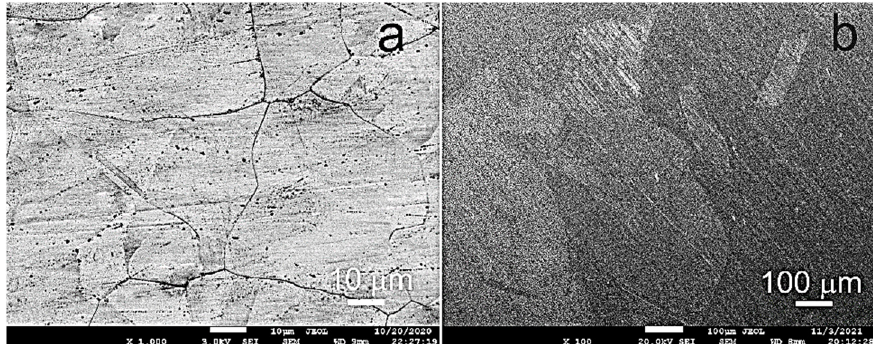
Figure 1. SEM images of the Fe–Mn–Pd alloy after forging ( a ) and annealing ( b ). Usually, during the deformation of Fe-Mn alloys, an γ → ε martensitic transformation occurs [34,35]. However, during four ECAP passes at a deformation temperature of 300 °C and 450 °C, the martensitic γ → ε transformation was not realized. X-ray phase analysis showed a completely austenitic state in the Fe-Mn-Pd alloy both in the initial (forged and annealed) and deformed states after ECAP at temperatures of 300 °C and 450 °C (Figure 2, Table 2). The dislocation density was determined by recalculating the microstrains obtained by complete fitting of the diffraction profile by the Rietveld method.